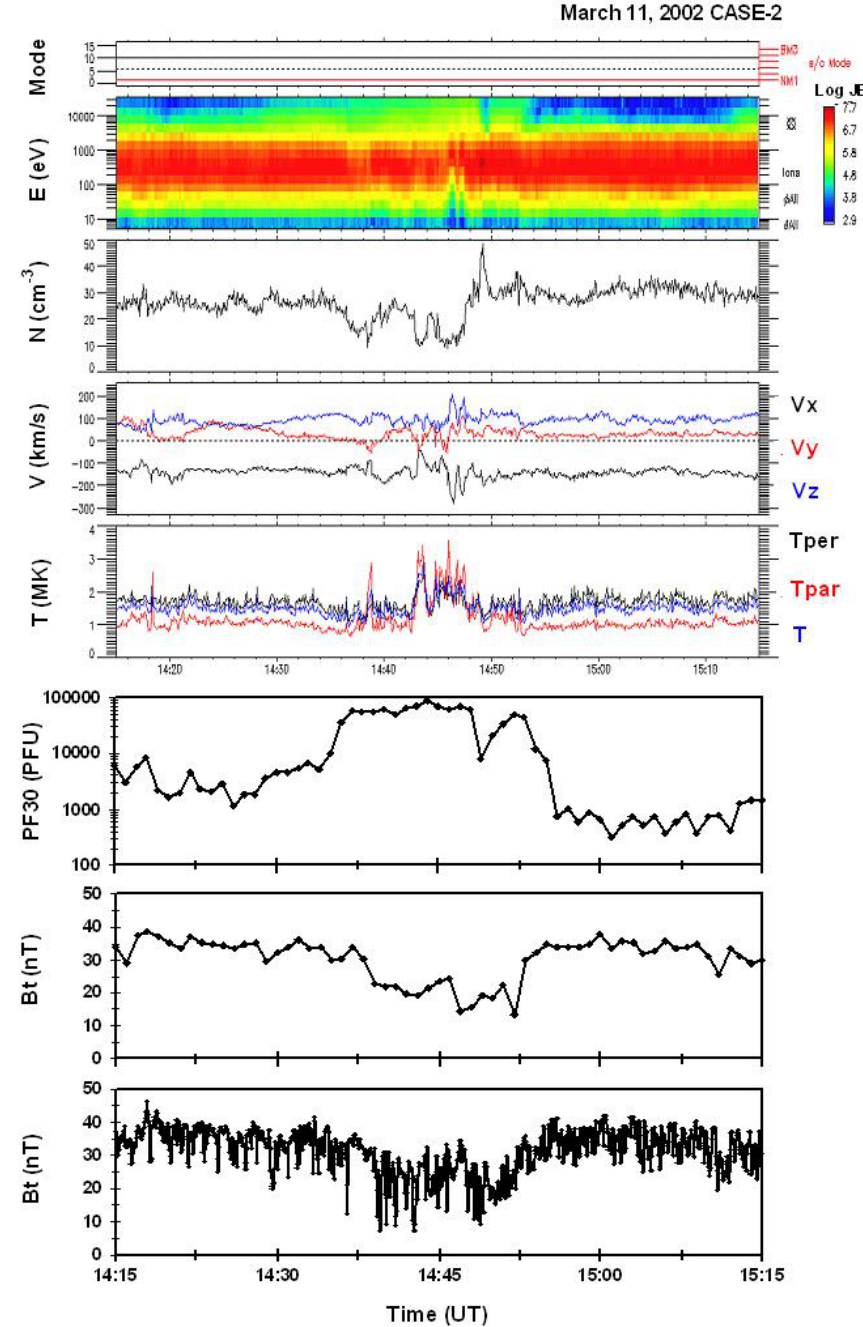
Figure 12 Fig. 12. Spectral plot for Burst 1 from 14:15 to 15:15UT in 11 March 2002 (Case 2). Panels from top to bottom are mode of the instrument,